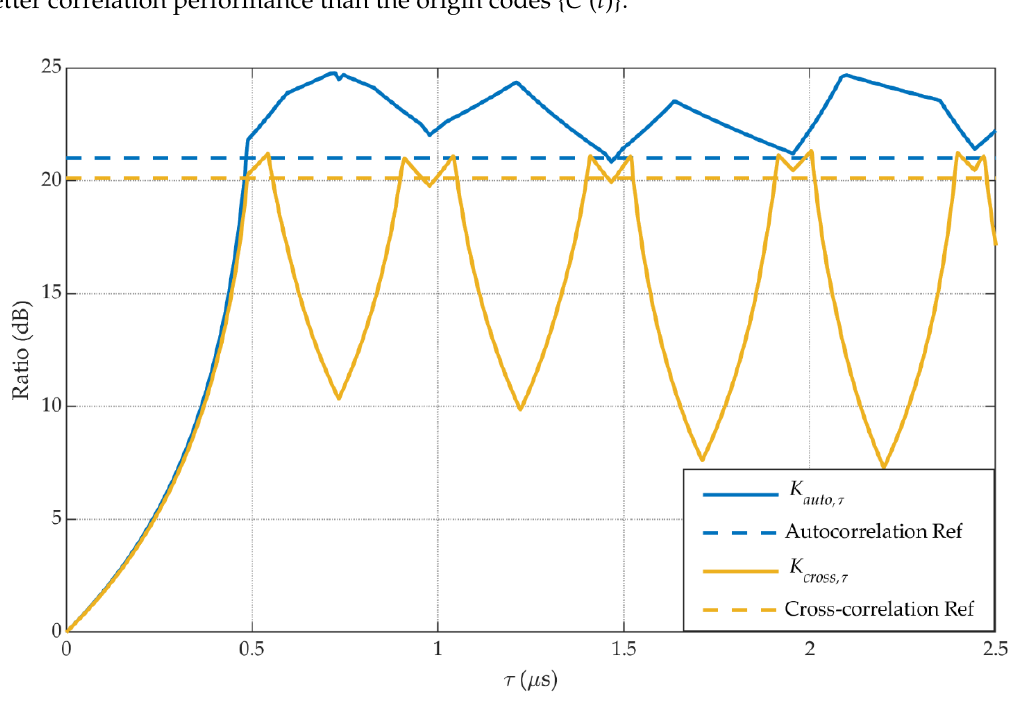
Figure 2. The correlation performance of the new ranging codes and the origin codes